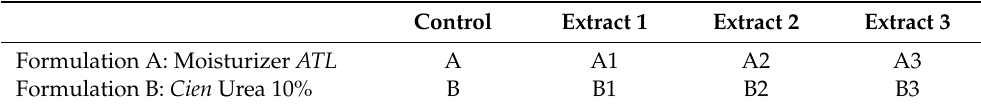
Table 3. Nomenclature of developed cosmetic